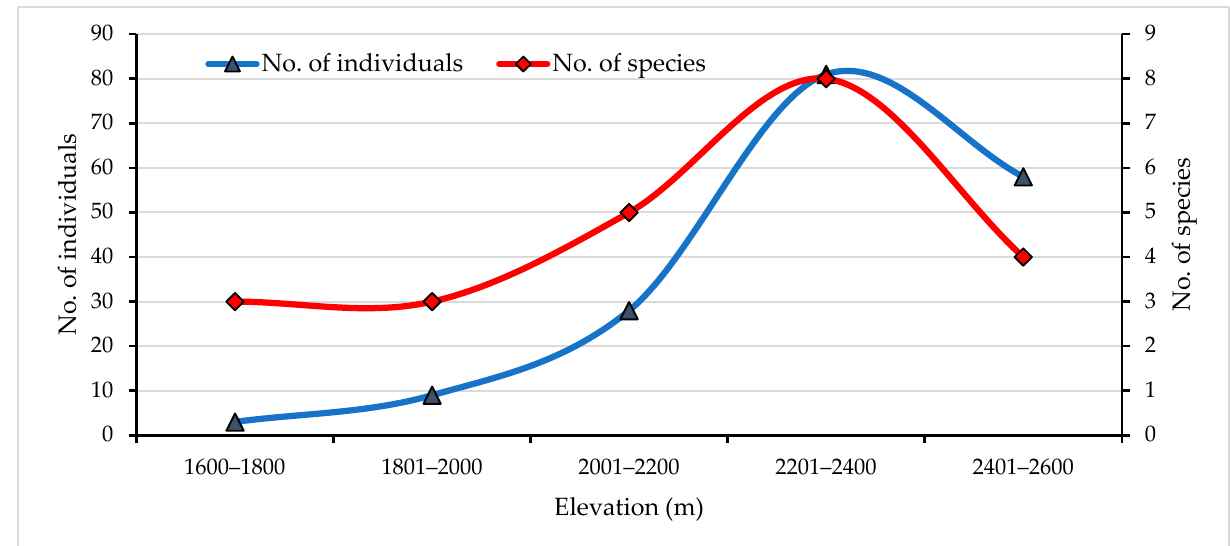
Figure 4. Herpetofauna species richness and abundance along elevational gradients in the RWC. Amphibians showed a statistically significant negative association with distance to water source (Table 4), suggesting that amphibian abundance tends to decline with increasing distance from water bodies. Amphibians are associated with moist environments [71,72]. As a proxy for water availability, soil moisture is a crucial predictor of amphibian occurrence [73]. The reptile abundance was positively linked with distance to water and negatively associated with elevation (Table 5). Greater species richness of lizards at higher elevations in southern latitudes have been reported because high elevations in southern latitudes experience exceptional variation in seasonal temperatures and soil moisture, which seem to benefit the physiological needs of lizards [74]. However, the cool, dry higher elevations of the Himalayan region support a smaller diversity of reptiles [54,72]. Distance to human settlements had a significant effect on herpetofauna in the RWC where both amphibian and reptile species were associated with distance from the nearest human settlement. Of all the 11 species of herpetofauna, L. tuberculata was found most frequently in the human habitats, such as on the roofs of houses and in holes in houses. This may be due to a greater availability of prey in and around the human habitat. Table 5. Summary of GLM showing the effects of environmental variables on the abundance of herpetofauna in the RWC.